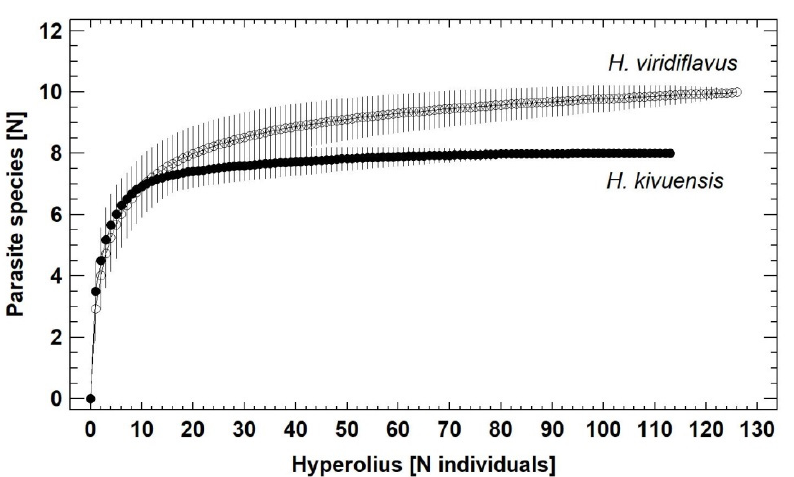
Figure 3. Rarefaction (species-saturation) diagram of parasite + endocommensal species richness in H. kivuensis and H. viridiflavus . Vertical lines give the standard deviation for each estimate.